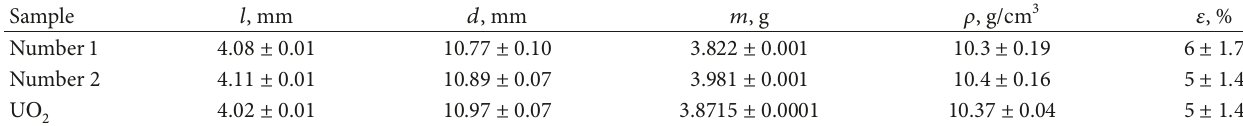
Table 4: Results of sample parameter measurements.